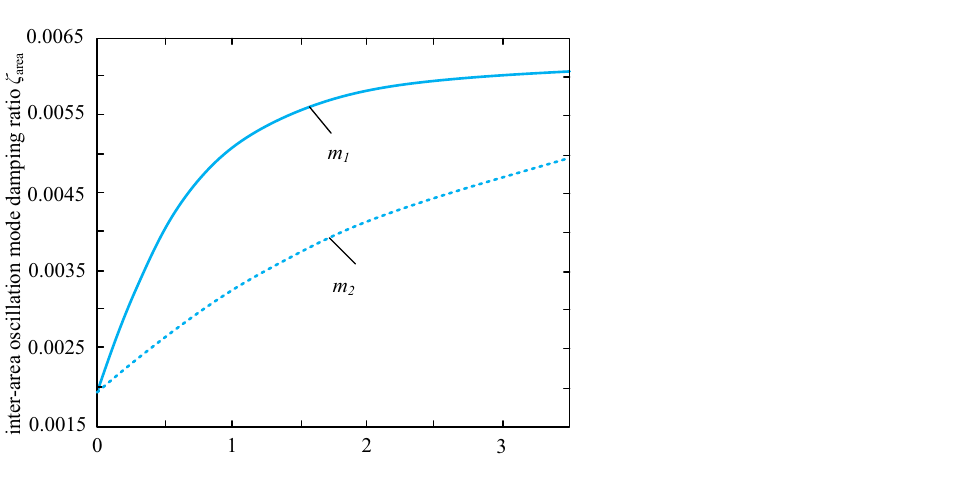
Figure 9. Changing trends of inter-area